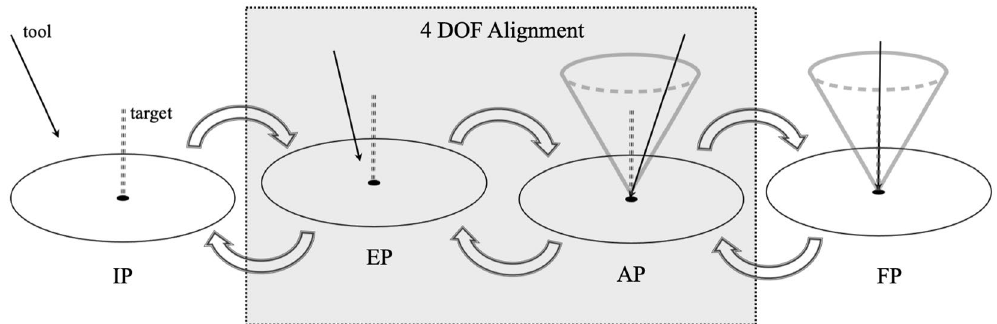
Figure 2. Four DOF alignment model with four phases, initial phase (IP), entry point phase (EP), angle phase (AP), and final phase (FP). EP and AP are two interactive phases with continuous mappings, whereas IP and FP are the static phases with constant mappings.